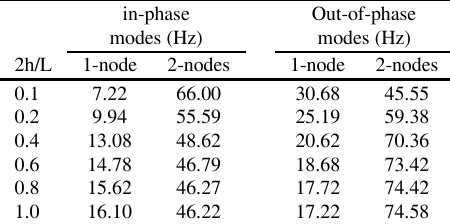
Table 3 Variation of natural frequencies to the parameter 2h/L